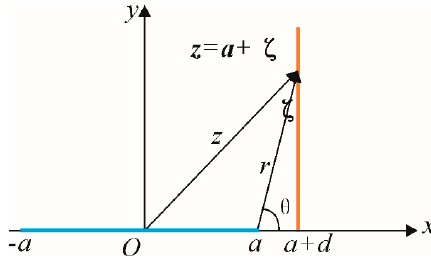
Figure 7. Model diagram of fractures with fluid pressure.